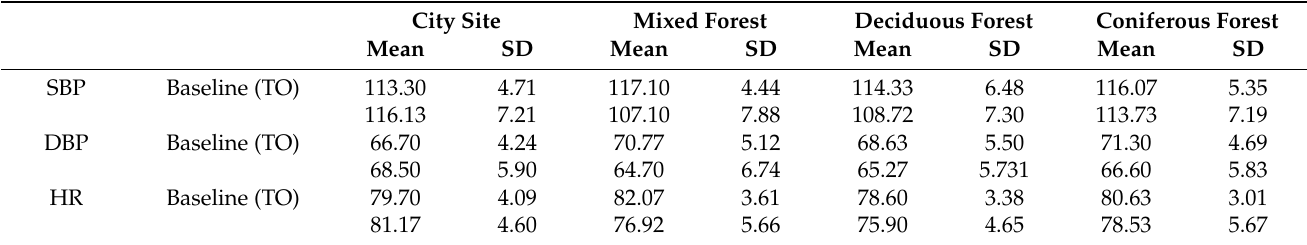
Table 3. Mean and standard deviation (SD) of physiological parameters (systolic blood pressure (SBP), diastolic blood pressure (DBP), and heart rate (HR)) in the four experimental